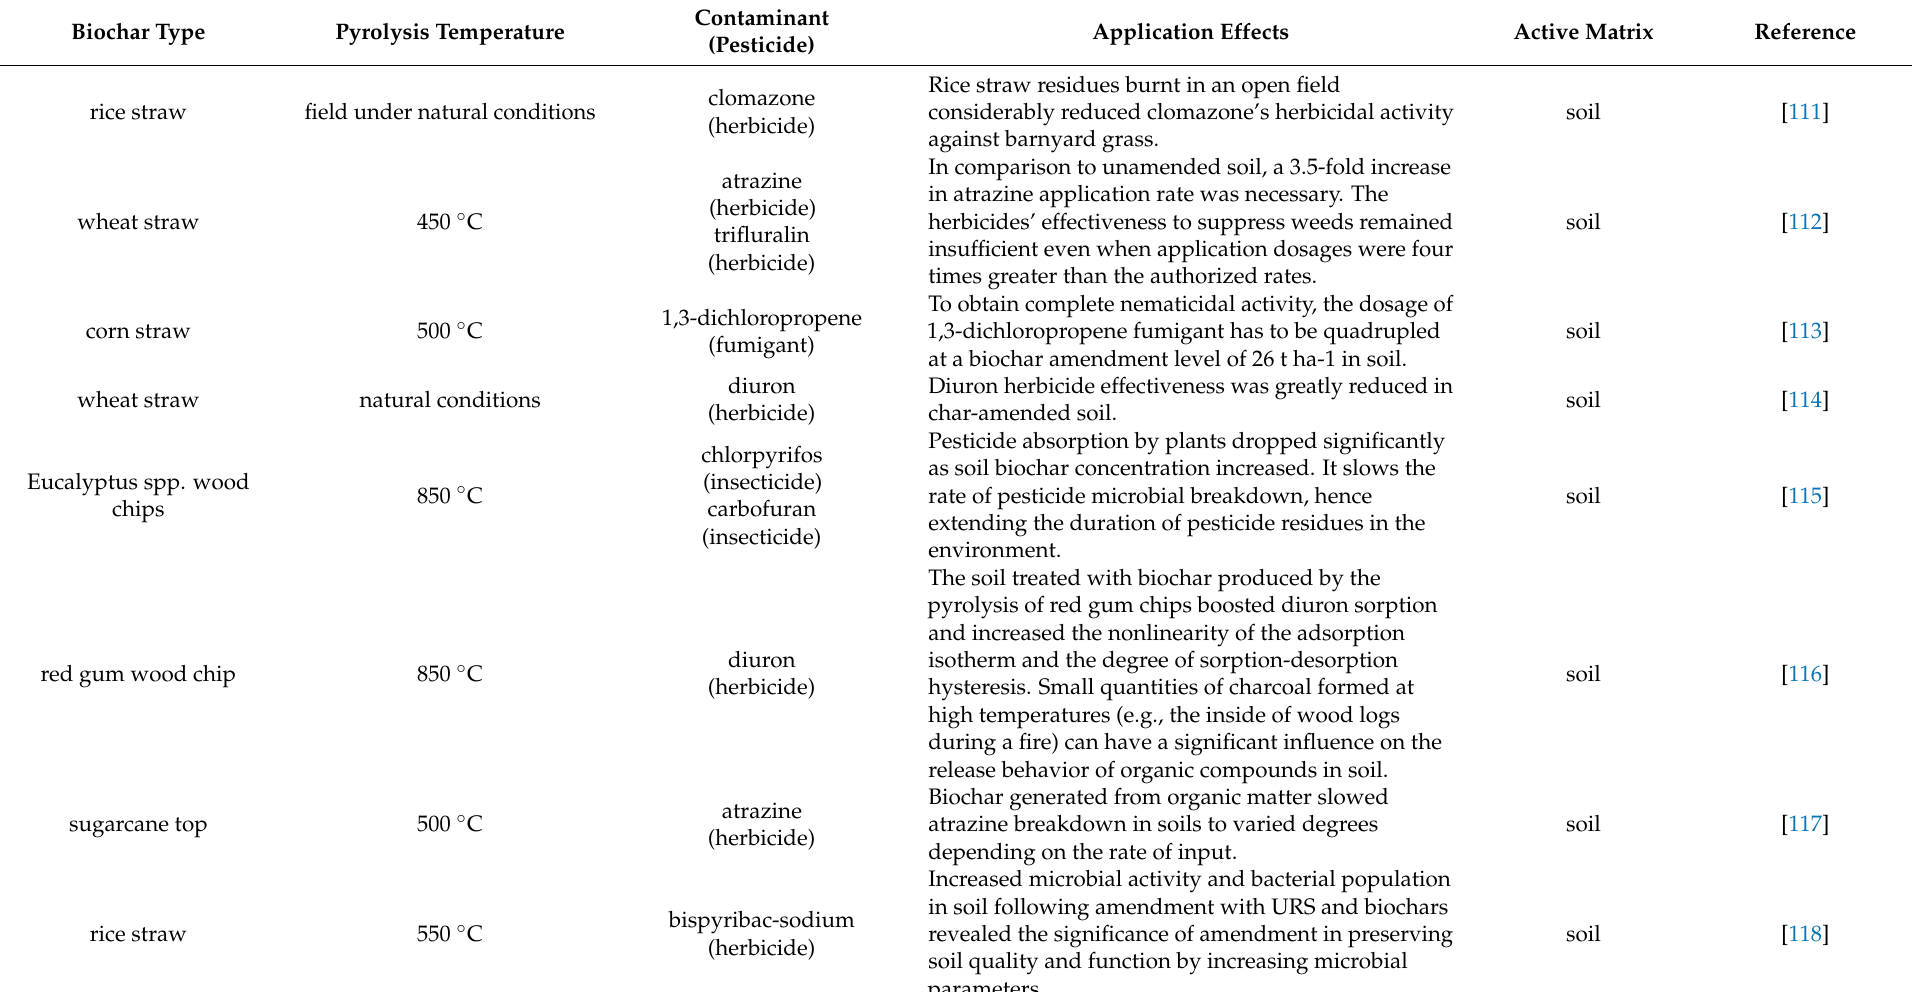
Table 3. Application of biochar in soil